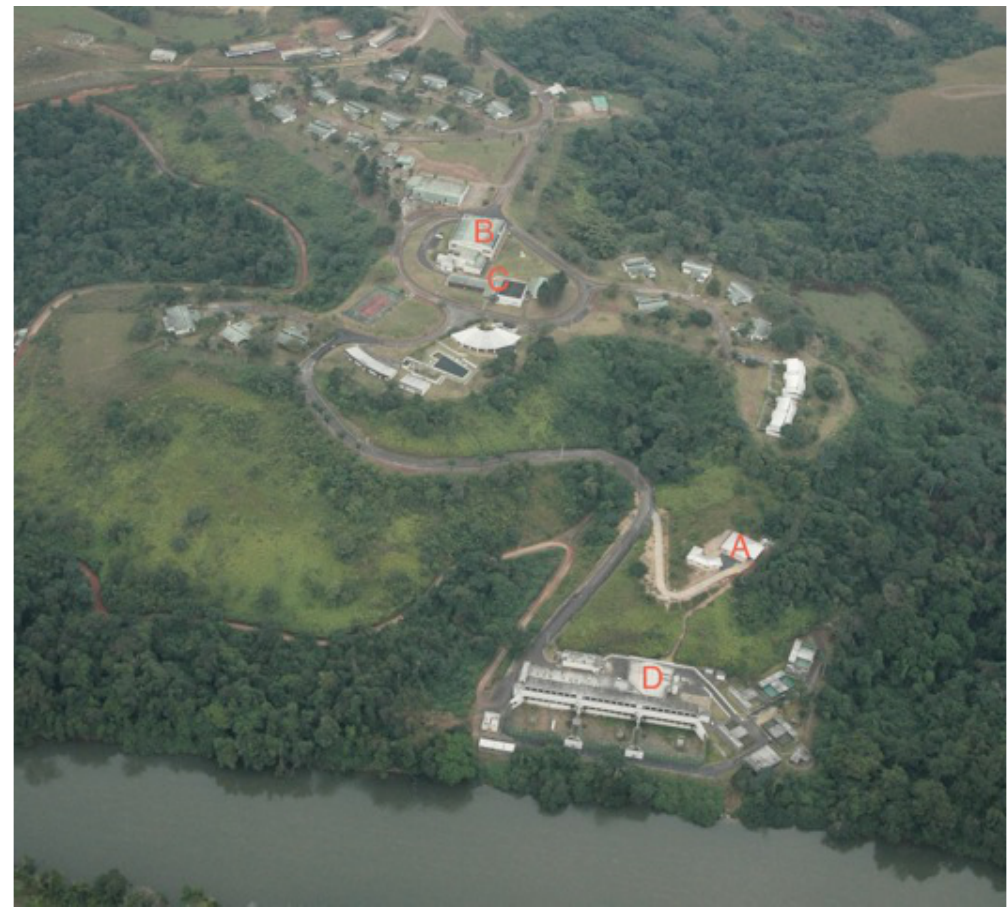
Figure 1. The International Centre for Medical Research of Franceville (CIRMF).